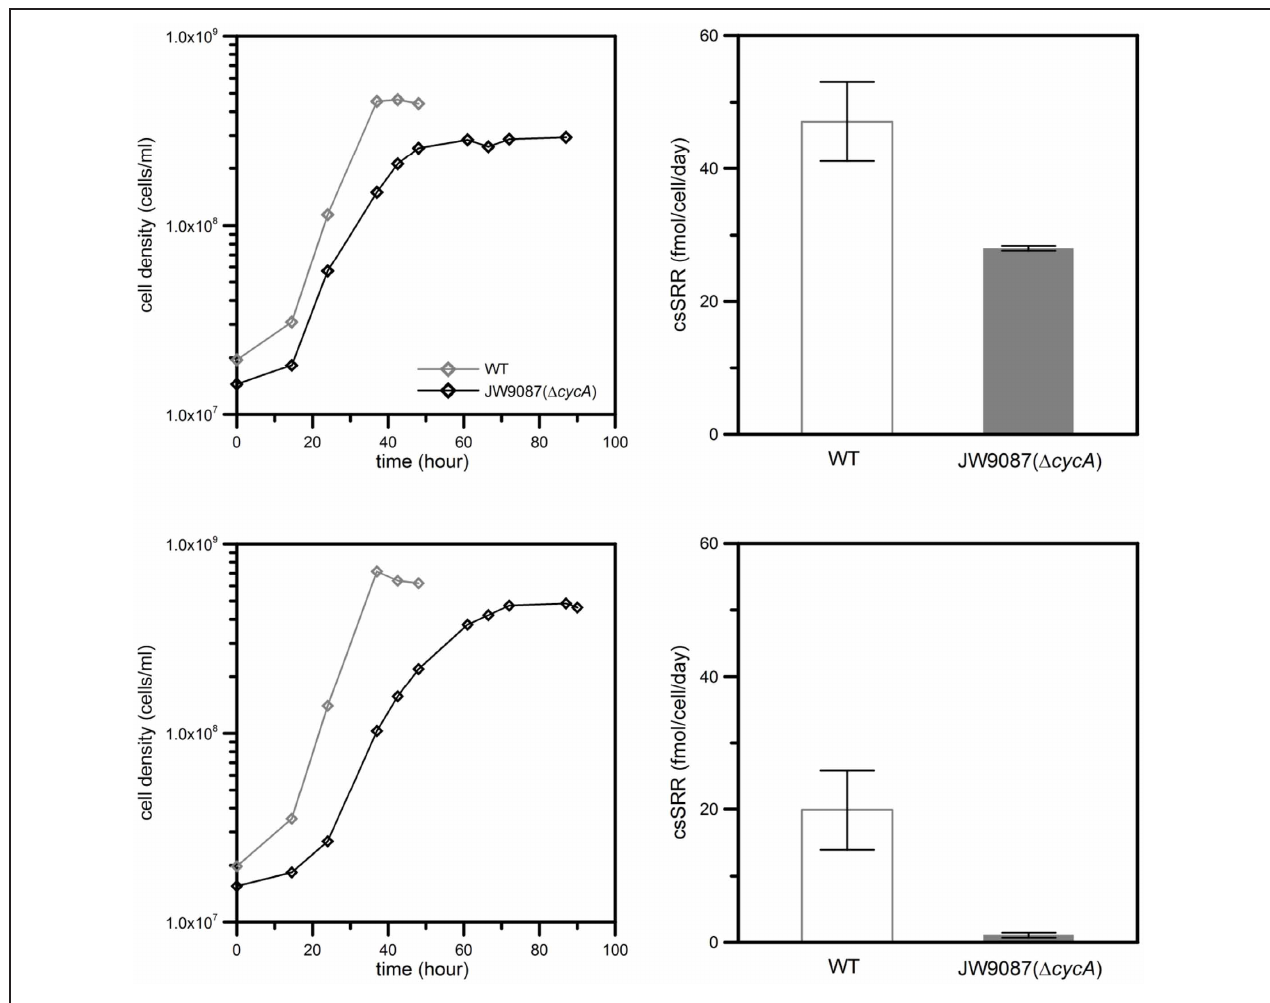
Growth curves are representative of two or more independent experiments. Errors for csSRR are given as the standard deviation of the mean.